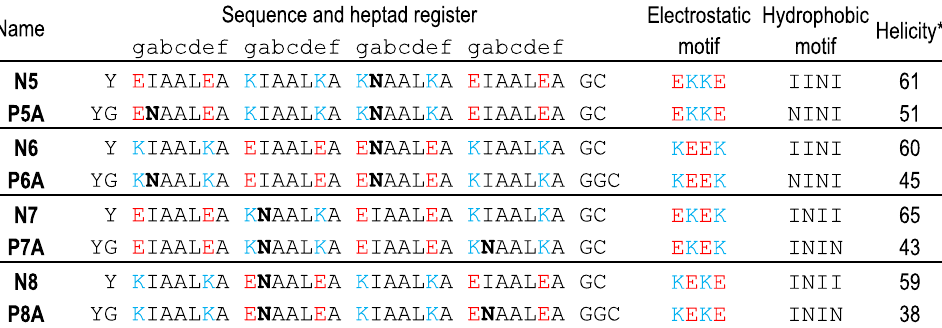
Table 1. List of N- and PA-type parallel heterodimers. Negative and positive amino acid residues are indicated with red and blue letters, respectively; asparagine is bolded. *value calculated according to the Agadir method 34